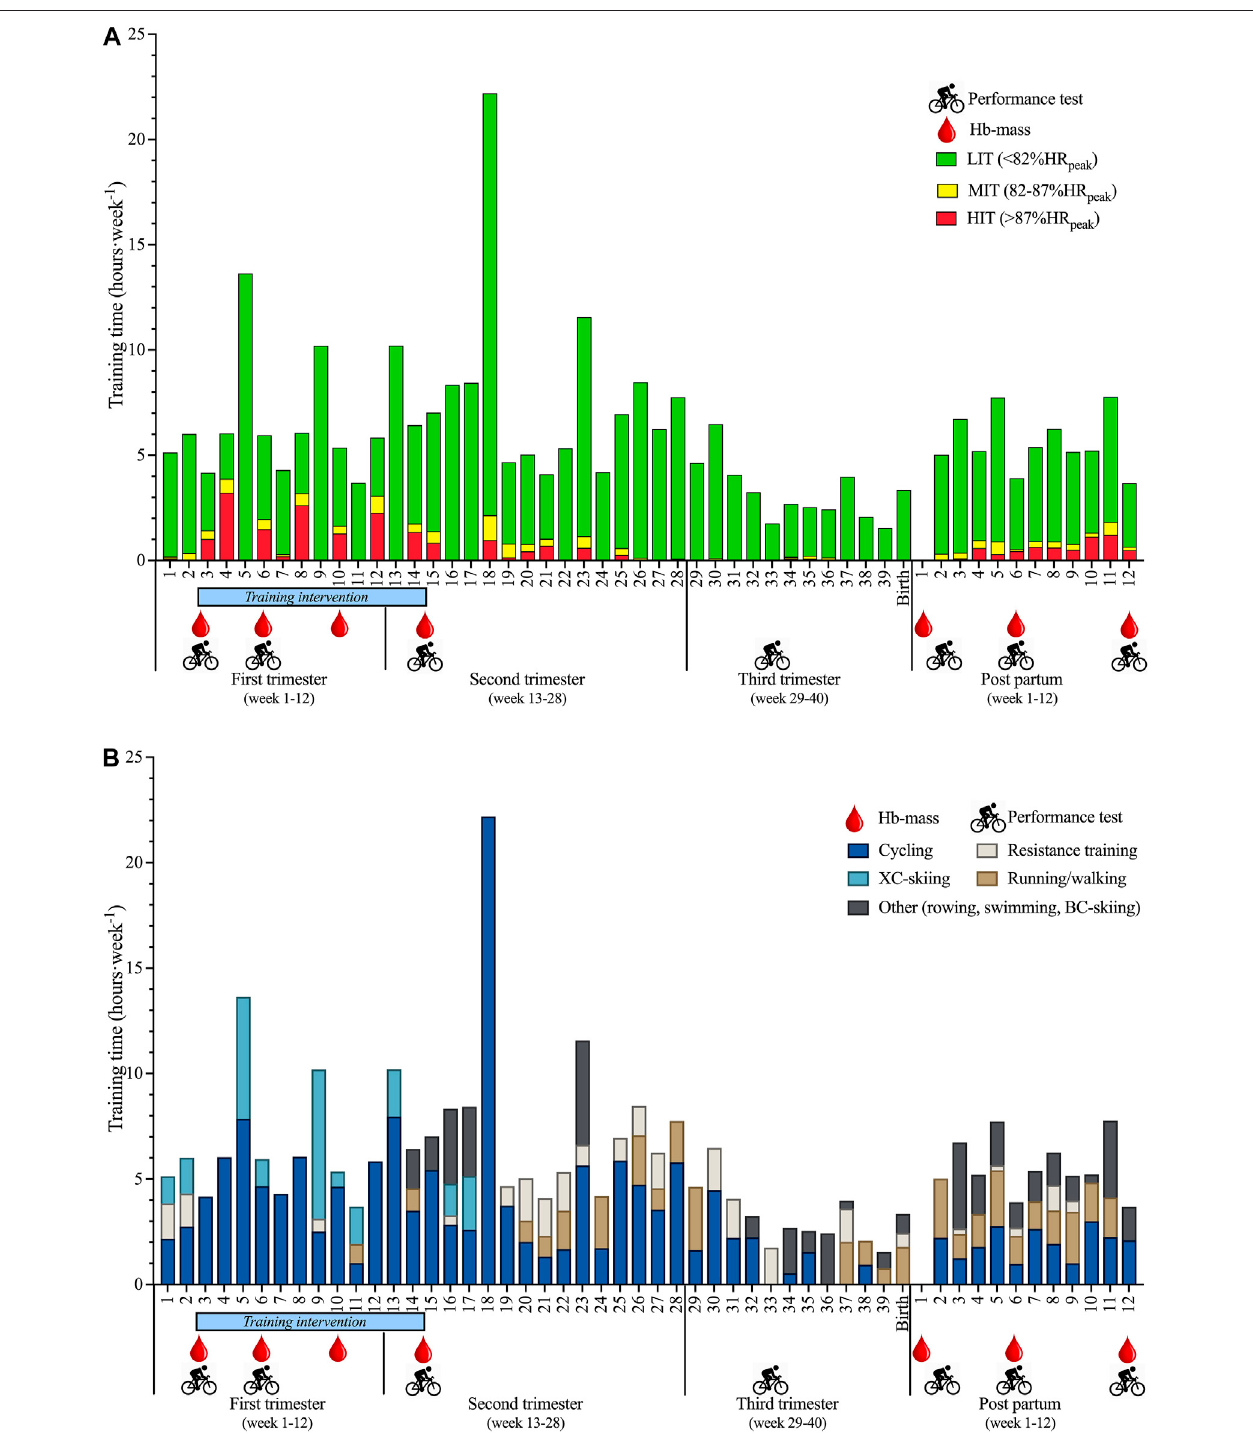
FIGURE 1 | (A) Schematic overview of experimental testing and exercise training distribution in three intensities (LIT, low-intensity; MIT, moderate-intensity; HIT, high-intensity training) as described previously (Seiler, 2010), and (B) exercise modalities before-, during pregnancy, and 12 weeks postpartum.